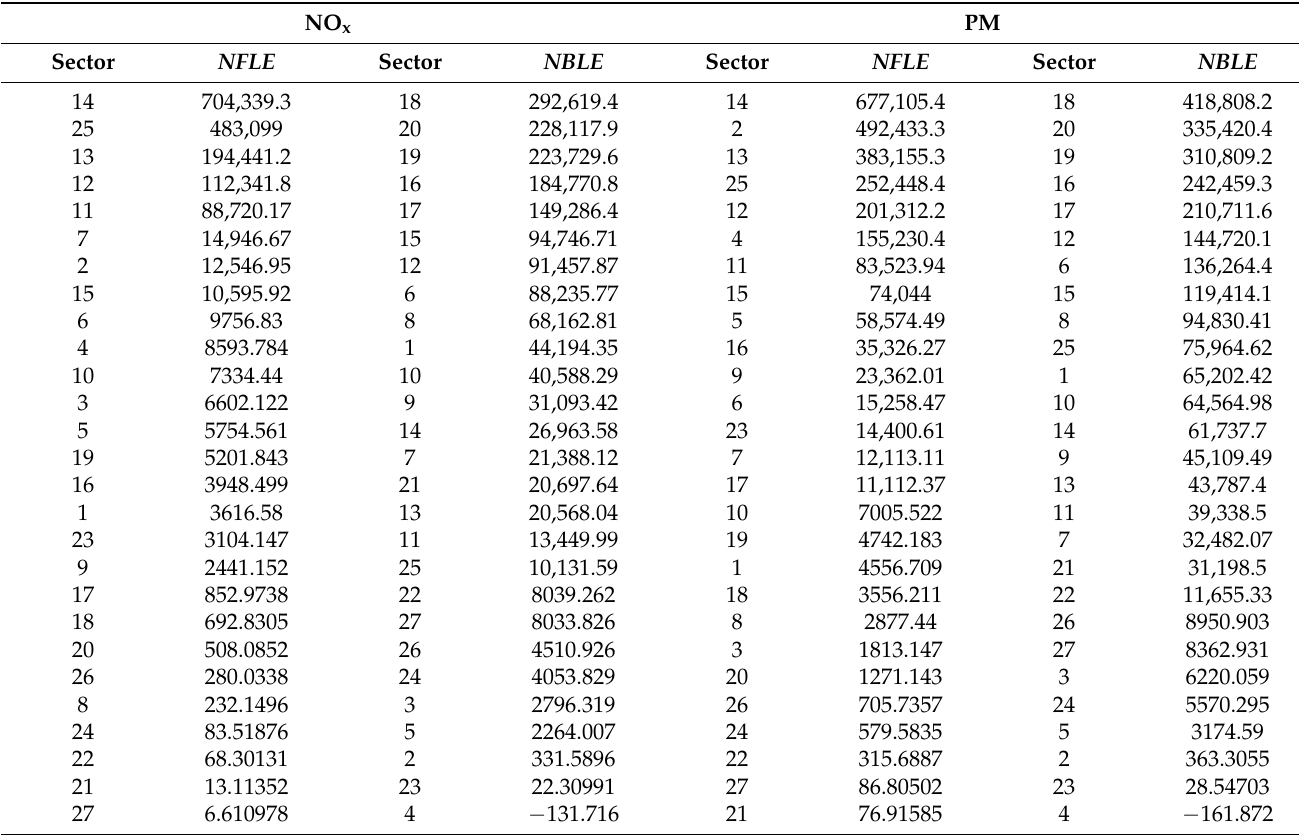
Table 3. Net forward and backward linkage emissions of 27